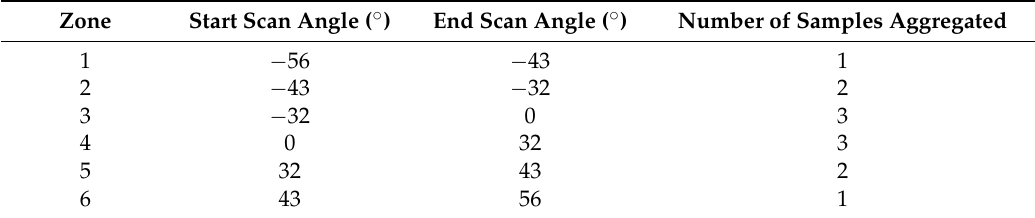
Table 2. Sample Aggregation Zones for Non-Day Night Bands